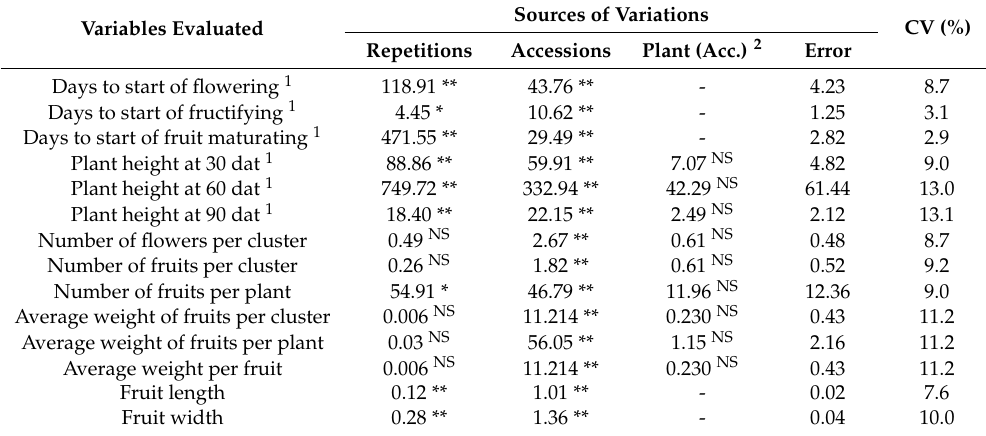
Table 2. Square means significance of agromorphological traits evaluated in eleven tomato accessions from El Salvador, Central America.